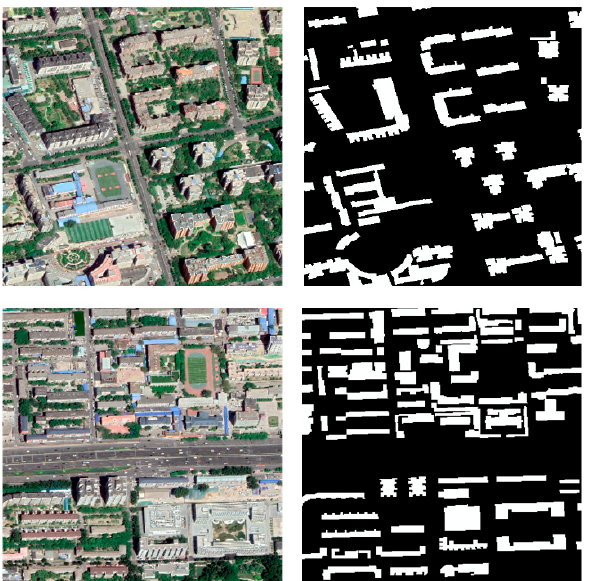
Figure 3. Examples of building extraction samples. The left column is the original image patches, and the right column is the corresponding label patches.